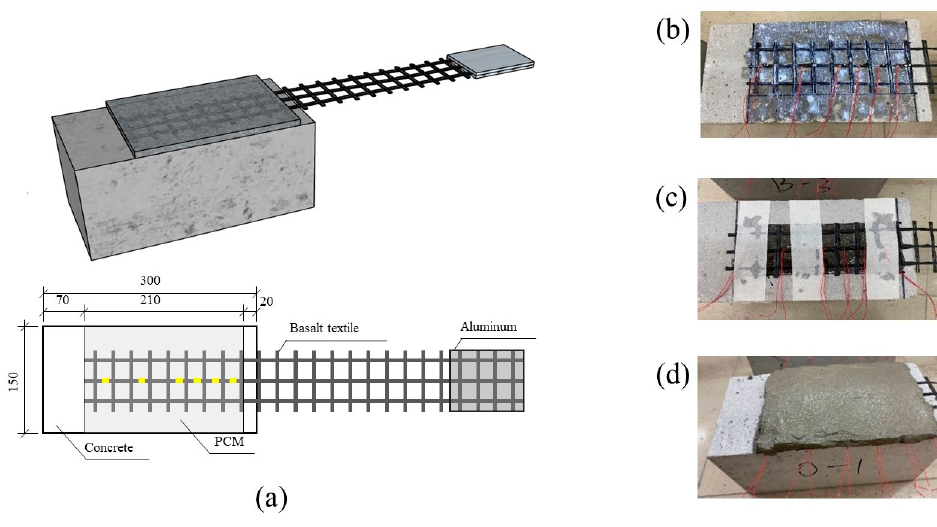
Figure 1. BTRM–concrete interface specimen arrangement ( a ) and preparation, including spreading adhesion promoter ( b ), applying impregnated resin ( c ), and covering PCM ( d ).